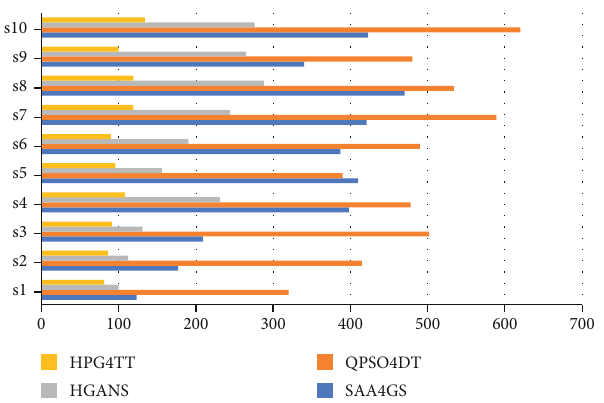
Figure 8: The comparison of the iterative times of nature-inspired metaheuristic